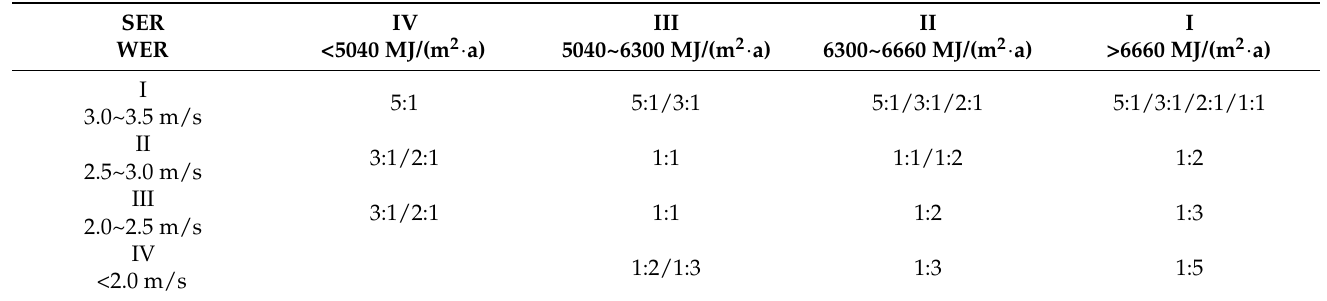
Table 8. Recommended installed capacity ratios of WT and PV for the hybrid system with different solar and wind energy